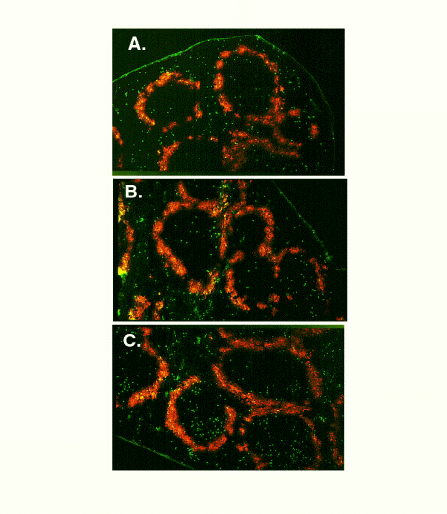
FIGURE 1. Time course of T lymphocyte accumulation in the white pulp of the spleen. 10 7 purified T cells labeled with CFSE were injected into the retro-orbital plexus of C57BL/6 mice. Spleens were harvested 30 (panel A), 60 (panel B), and 90 (panel C) min after injection. The white pulp is delineated by the red staining of metallophilic macrophages using MOMA-1 (Rat IgM) bound to PE labeled anti-Rat IgM; the CFSE labeled cells appear green. Similar results were obtained in two additional experiments.